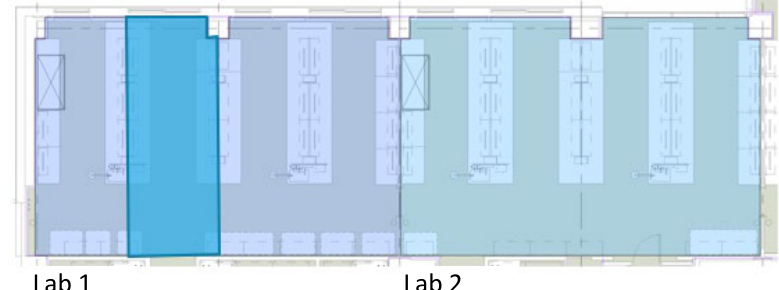
Figure 3 Lab modules are the unit of space for laboratory design that enable flexibility for future modifications (Image copyright: Author).